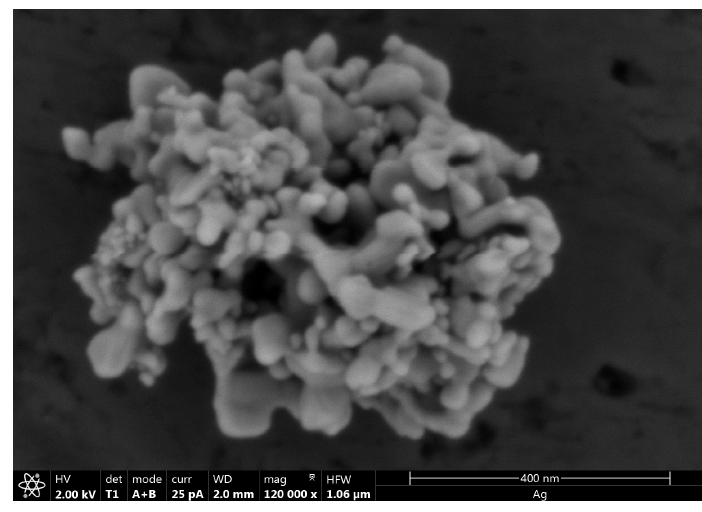
Figure 10. SEM micrograph of a representative aggregate of the ‘as received’ silver nanoparticles.